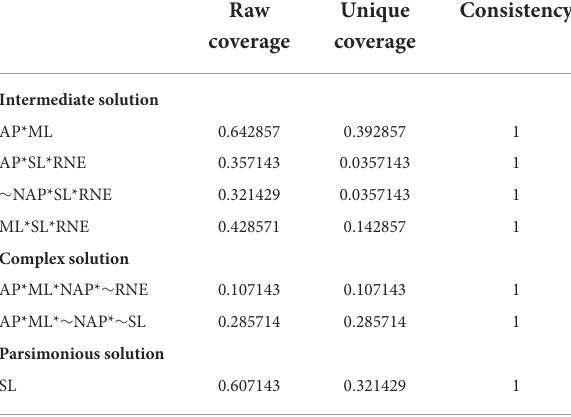
TABLE 5 Antecedent condition configurations for resettlees’ request to change the resettlement